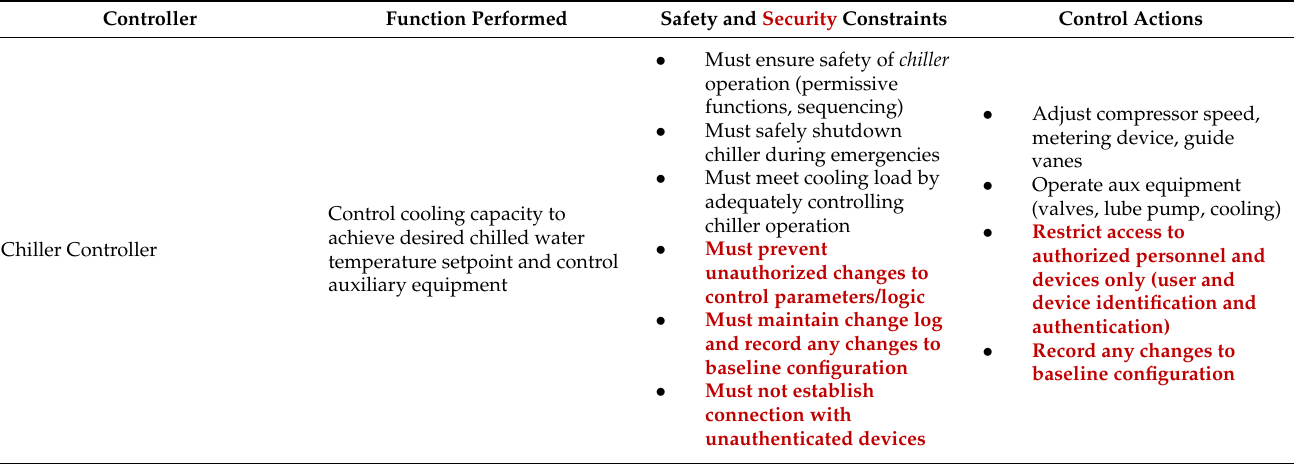
Table 2. Partial List of Controllers, Safety Responsibilities and Control Actions (items in red are security